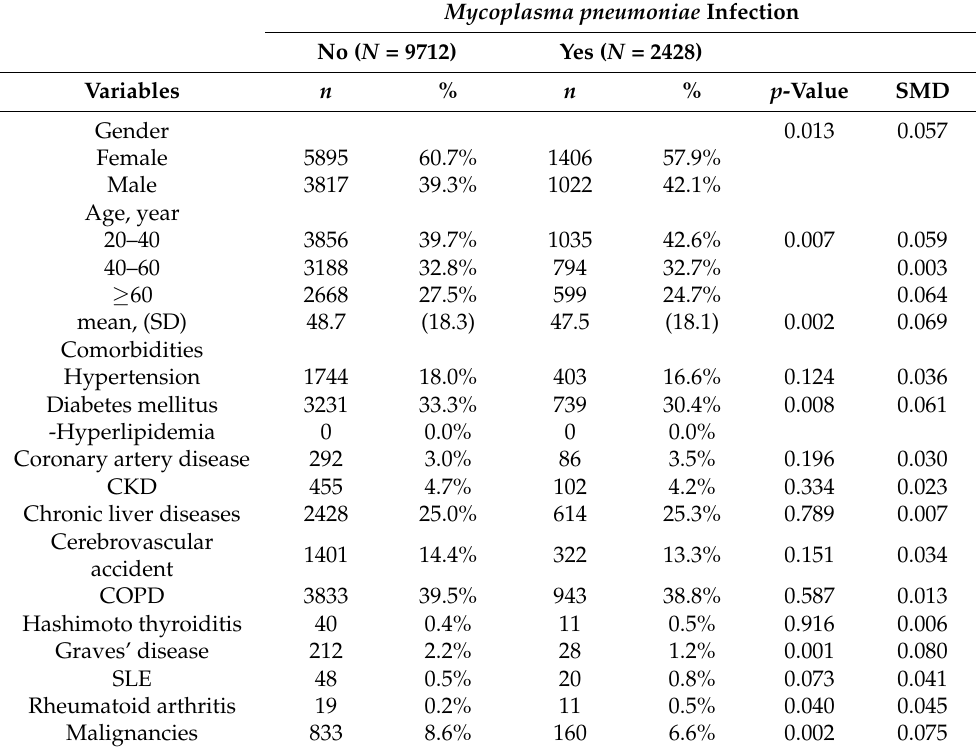
Table 1. The baseline characteristic and comorbidities of patients with and without Mycoplasma pneumoniae ( M. pneumoniae ) infection in cohort